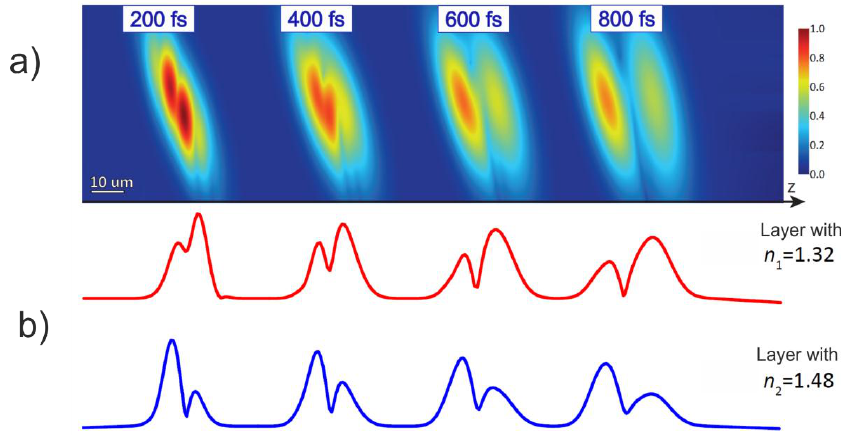
Figure 2. Finite difference time domain (FDTD) calculation of the propagation of a 30 fs laser pulse through a PhC in the Laue scheme of the dynamical Bragg diffraction; the PhC layers are parallel to the z -axis (shown in panel a) and perpendicular to the plane of the figure. ( a ) Spatial distribution of the pulse intensity after the laser pulse travels for 200 fs, 400 fs, 600 fs and 800 fs inside a PhC; ( b ) cross-sections of the panel a made for the layers of low porosity (upper red curve) and of high porosity (bottom blue